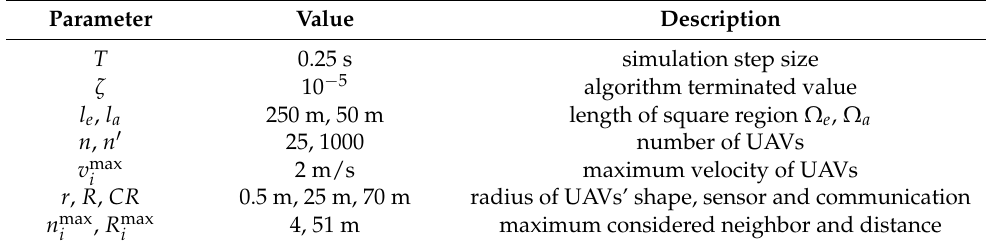
Table 2. Simulation parameters.